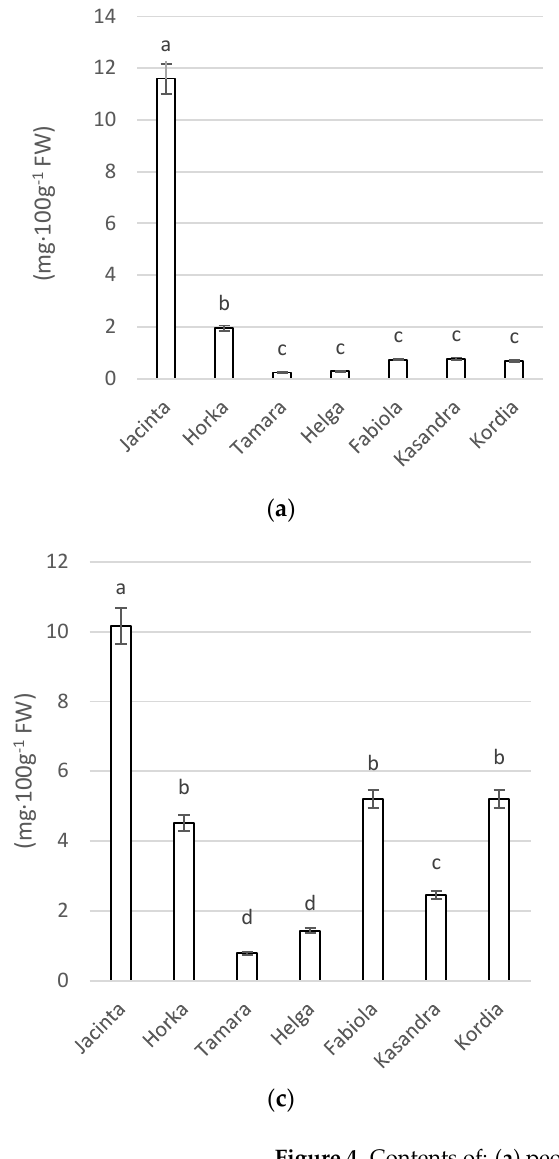
Figure 4. Contents of: ( a ) peonidin-3-rutinoside; ( b ) cyanidin-3-rutinoside; ( c ) cyanidin-3-galactoside, depending on cultivar. Values with different letters are significantly